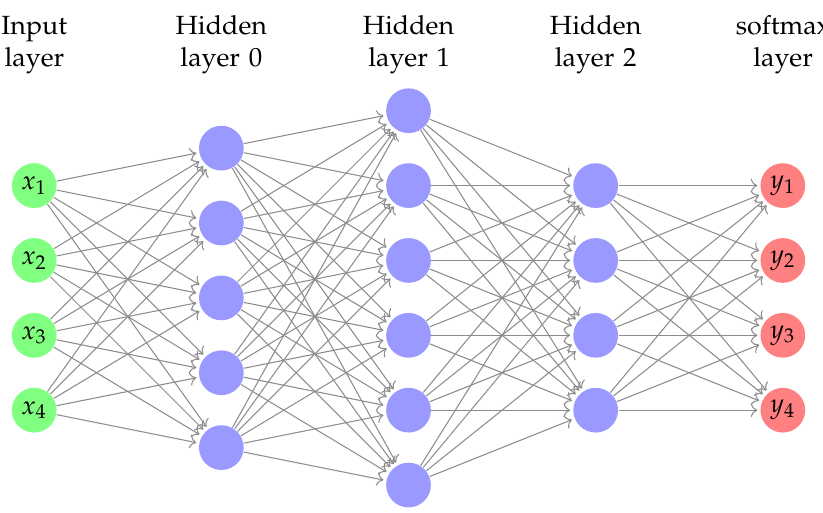
Figure 1. A typical Deep Learning Network